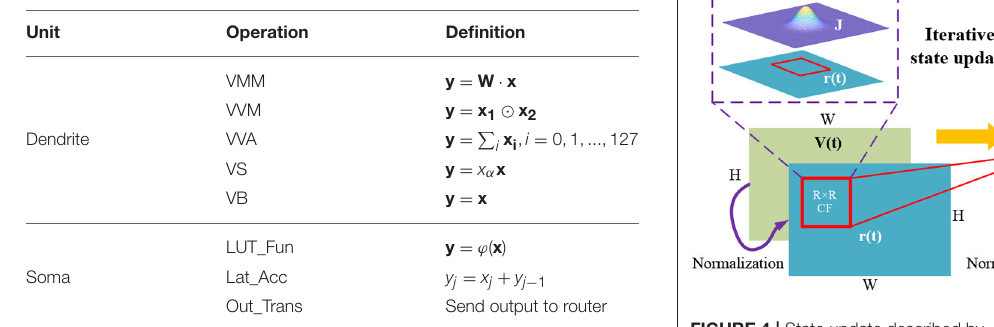
TABLE 1 | Dendrite and soma operations.